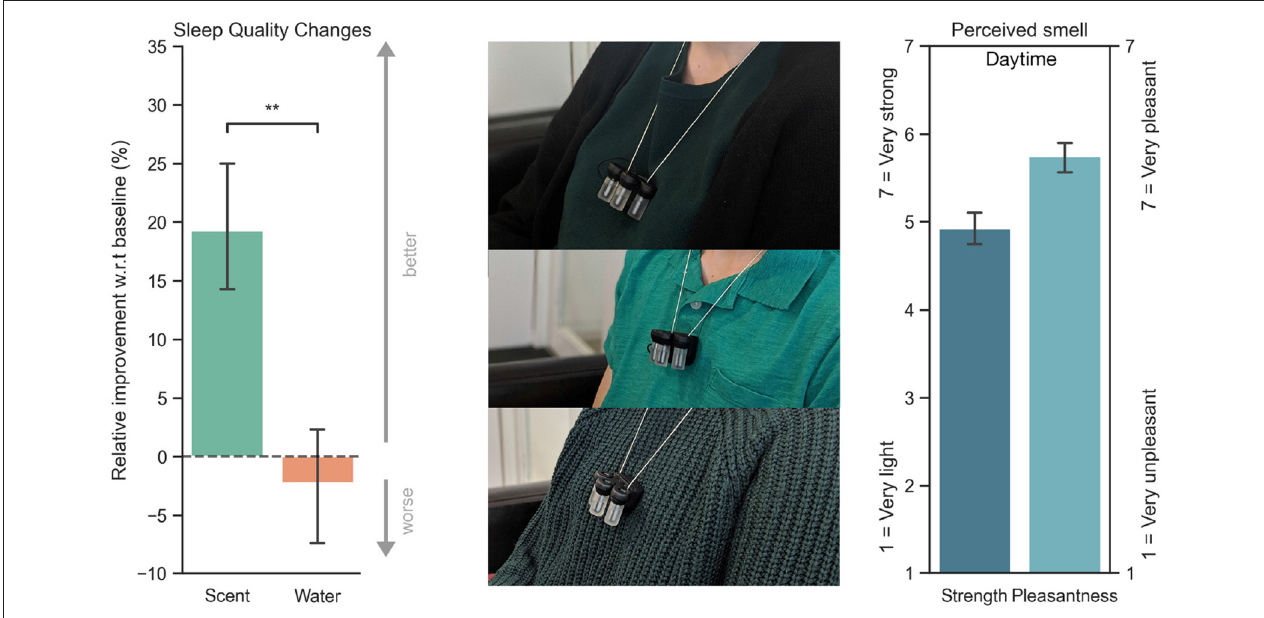
FIGURE 7 | Participants wearing the prototype during the daytime olfactory test. As seen in the right image, participants rated how strong (1 = Very light, 7 = Very strong) the fragrance was, as well as how pleasant (1 = Very unpleasant, 7 = Very pleasant). On the left, self-reported relative improvement with respect to their sleep quality on a baseline night. There was a significant improvement when comparing scent with control (water). ** P <